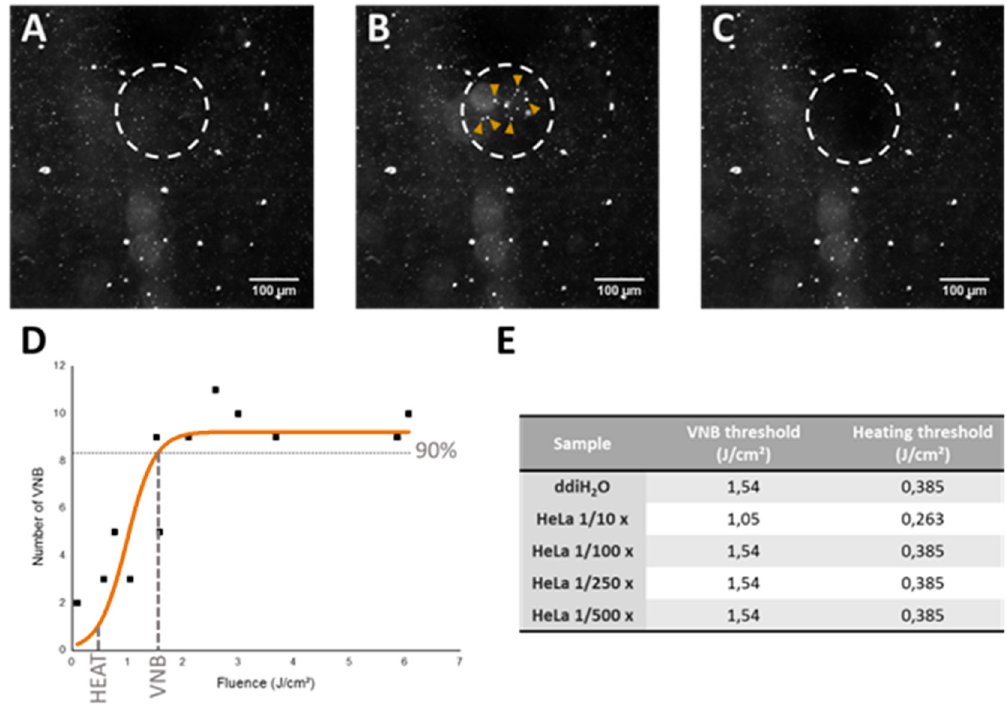
Figure 5. Determination of heating and VNB threshold via dark-field microscopy. ( A ) dark-field microscopy image of JetPEI/pDNA/AuNP 5 pt complexes in ddiH 2 O; ( B ) dark-field microscopy image upon VNB formation (VNBs indicated by yellow arrows); ( C ) dark-field microscopy image after VNB formation. Scalebar on the images represents 100 µ m; ( D ) graph shows the relation between the number of VNBs and laser fluence. VNB threshold is calculated as the laser fluence needed to reach 90% of the maximum number of VNBs. The fluence for heating is selected at one-fourth of the VNB threshold; ( E ) the table shows the threshold values for VNB formation and heating (in J/cm 2 ) used for JetPEI/pDNA/AuNP 5 pt complexes in further experiments.